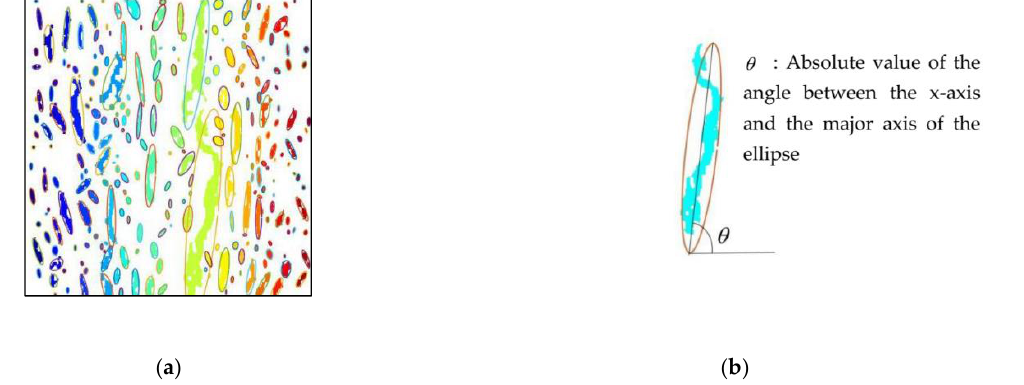
Figure 3. An example of ( a ) the connected component map and ( b ) the bounding ellipse.